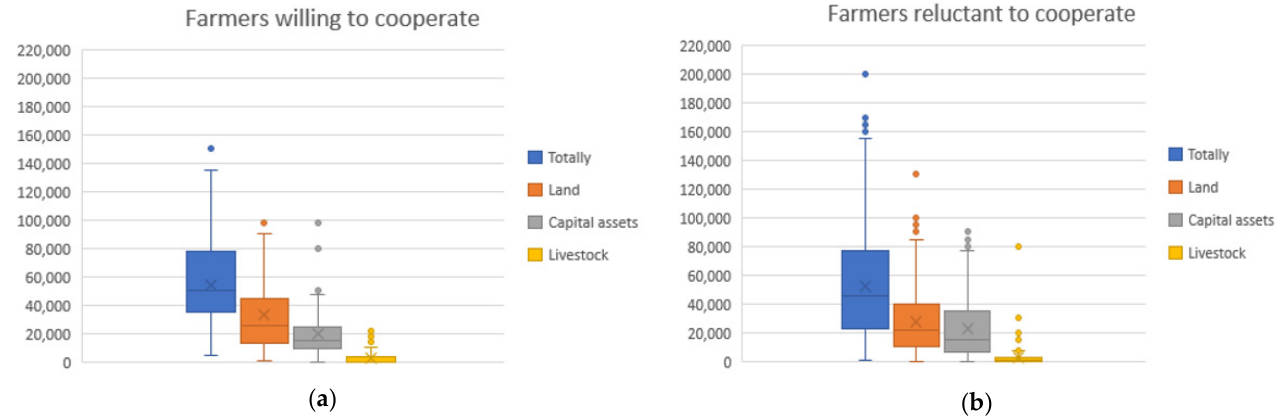
Figure 12. Farm assets in groups of small farms willing to cooperate ( a ) and reluctant to cooperate ( b ) (N = 1002).